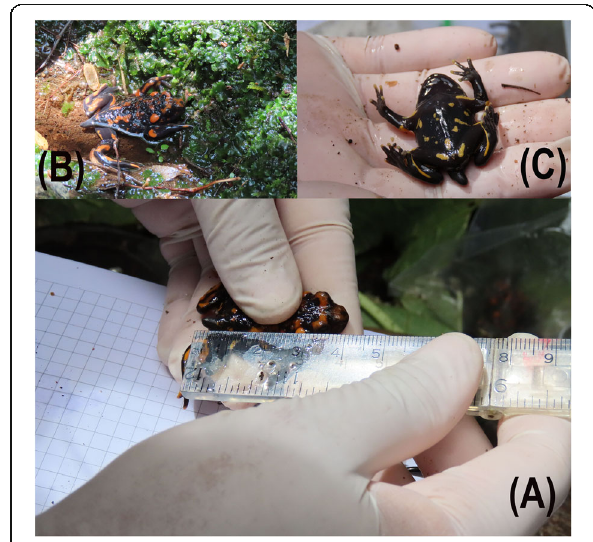
Fig. 3 a Metamorficos de T. venustus , con tamaños de entre 40 a